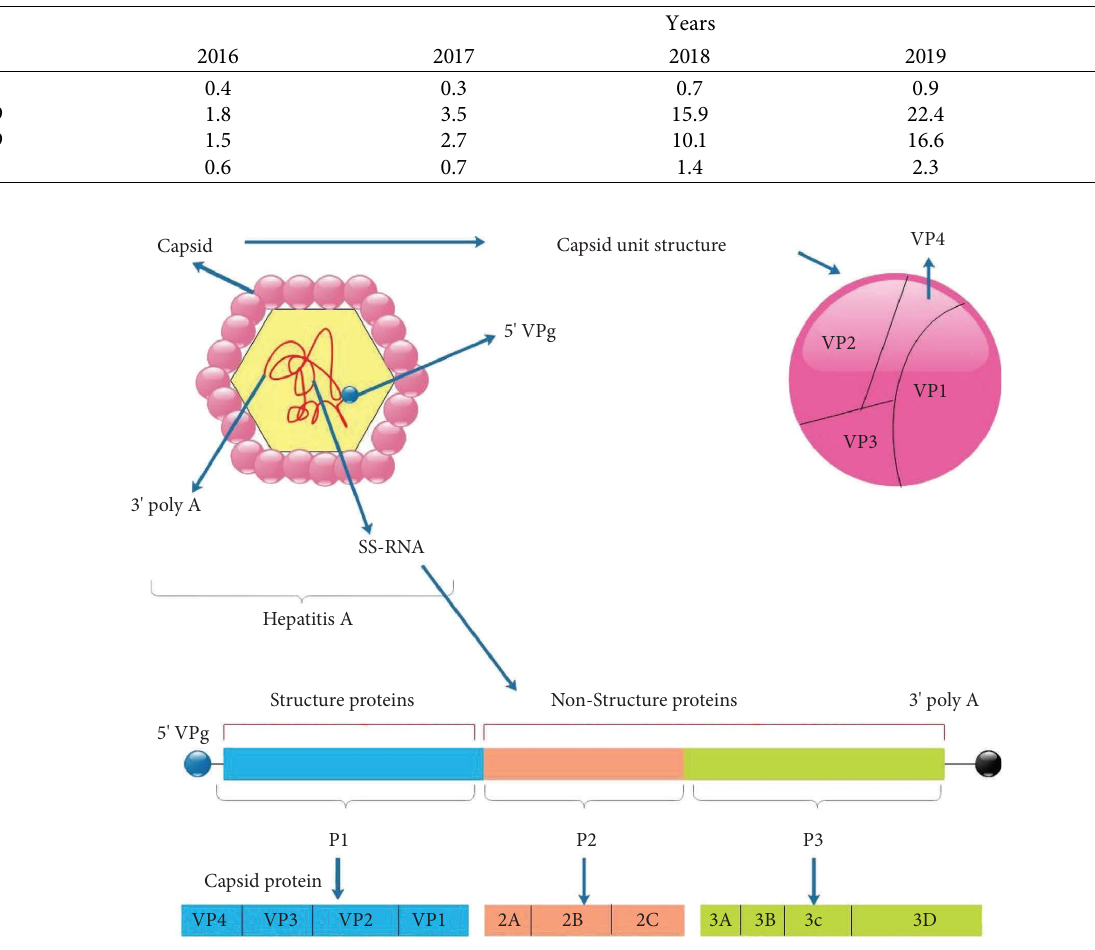
Figure 1: P1 1A-VP4, 1B-VP2, 1C-VP3, and 1D-VP1 are structural protein components making up the capsid polypeptide. P2 comprises of three nonstructural polypeptides: 2A, 2B, and 2C, all required for viral replication. P3 consists of four nonstructural proteins: 3A anchors the replication component to the cell membranes, 3B is a protein that is also called VPg. At the same time, 3C is a cysteine protease that breaks down polypeptides into proteins, and 3D is an RNA polymerase that requires RNA to